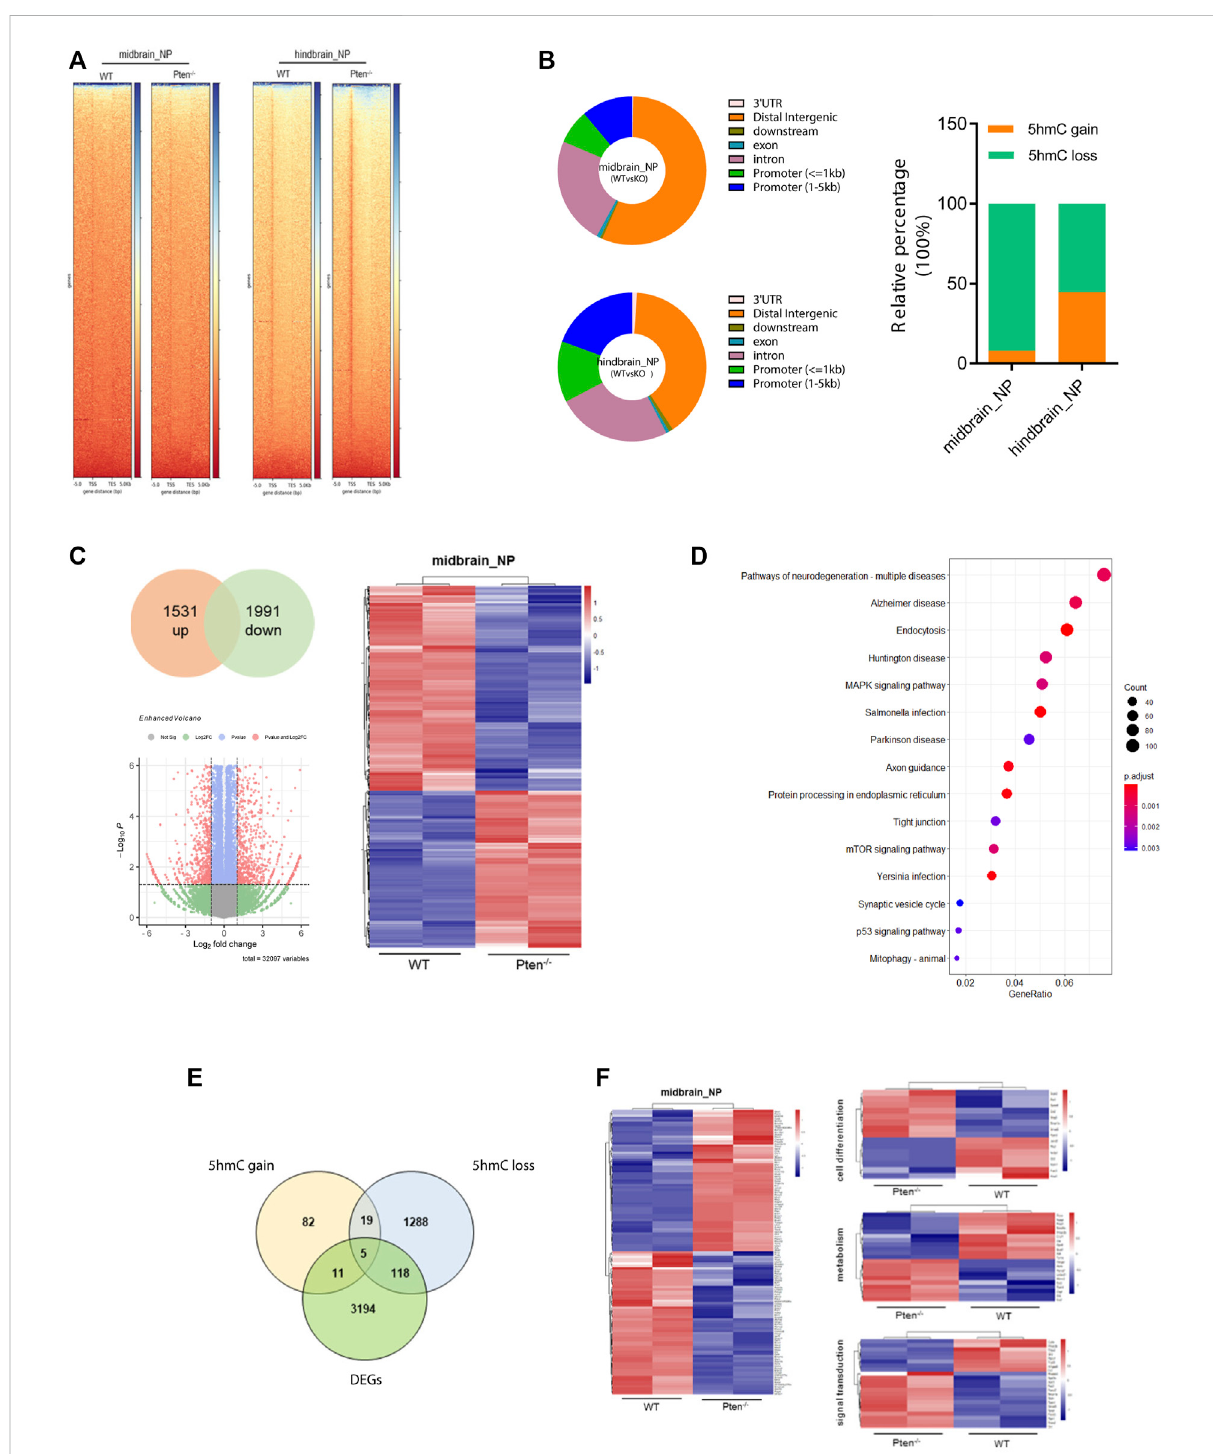
FIGURE 5 Pten − / − associated global DNAhydroxymethylation changes during neurogenesis. (A) Heatmap representation of 5hmC densities within 5 kb of transcription start site (TSS) and transcription end site (TES) in WT and Pten − / − ESCs in midbrain and hindbrain progenitor cells. (B) Genomic distribution of 5hmC-enriched regions in progenitor cells. (C) Transcriptional analysis of genes in WT and Pten − / − ESCs in midbrain progenitor cells. Volcano plots (left) and heatmaps (right) were shown. (D) KEGG pathway enrichment analysis identi fi ed pathways associated with neurodegenerative diseases. (E) Venn diagram showing overlap of upregulated DhMRs, downregulated DhMRs and DEGs in WT and Pten − / − ESCs- derived midbrain progenitor cells. (F) Heatmap of the 123 DEGs with 5hmC loss enriched pathways associated with cell differentiation, signal transduction, and